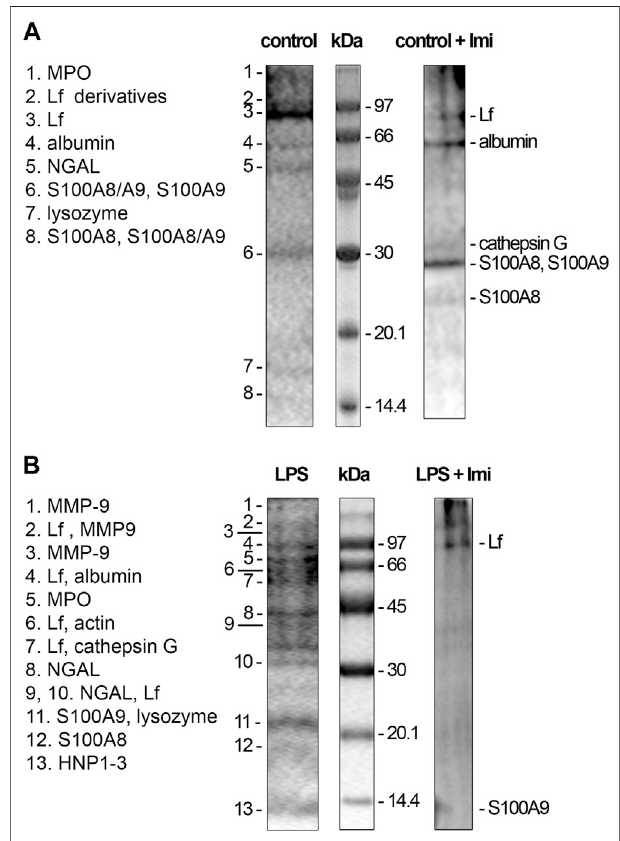
FIGURE 5 | Inhibition of protein secretion of control and LPS-treated neutrophils during adhesion to fi bronectin by imipramine. (A) Human neutrophils were attached to fi bronectin-coated substrates during 25 min incubation under control conditions or in the presence of 100 μ M imipramine. (B) Human neutrophils were attached to fi bronectin-coated substrata for 25 min in the presence of 10 μ g/ml LPS or 10 µg/ml LPS in combination with 100 μ M imipramine. Samples of extracellular medium were collected, and proteins were extracted and subjected to separation in 15% SDS-PAGE under unreduced conditions. Gels are stained with Coomassie brilliant blue. Pictures represent typical protein pro fi les observed in the three independent experiments.